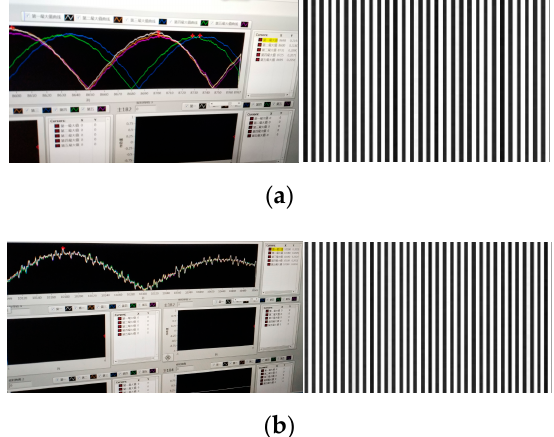
Figure 13. Test site of the modulation transfer function (MTF).